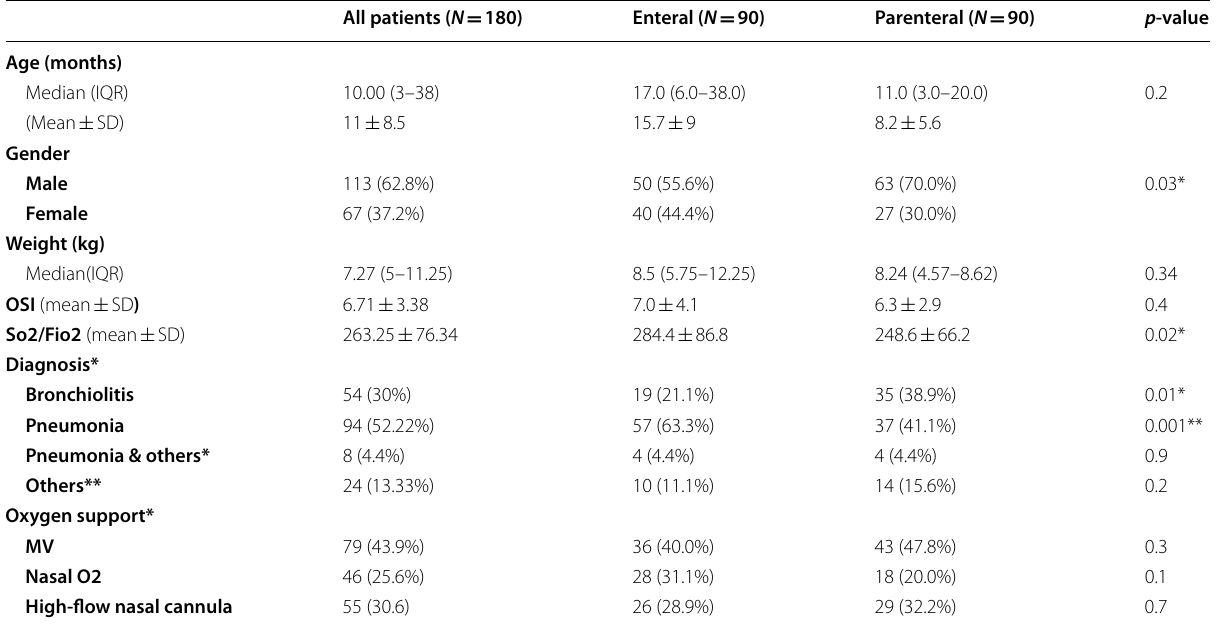
* MV Mechanical ventilation, OSI Oxygen saturation index, S/F SO2/FIO2 ratio P -value calculated depends on logistic regression analysis. * P -value < 0.05 is significant. ** P -value < 0.01 is highly significant * Pneumonia and others include the following: myopathy, Guillain–Barre syndrome, Arnold Chiari, bronchiectasis, chronic heart disease, gastroenteritis, pneumothorax, dilated cardiomyopathy, empyema, heart failure. ** Others include the following: foreign body aspiration or Guillain–Barre syndrome * Age and weight are represented as median with interquartile range (25–75%); the data were analyzed by Mann–whitney U -test. While sex, diagnosis categories, and oxygen support are represented as frequency and percent, the data were analyzed by Χ 2 test. But indices are represented mean